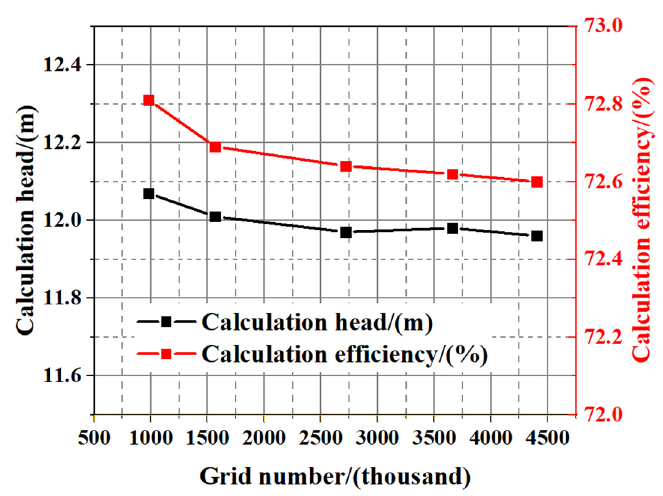
Figure 3. The grid independence.